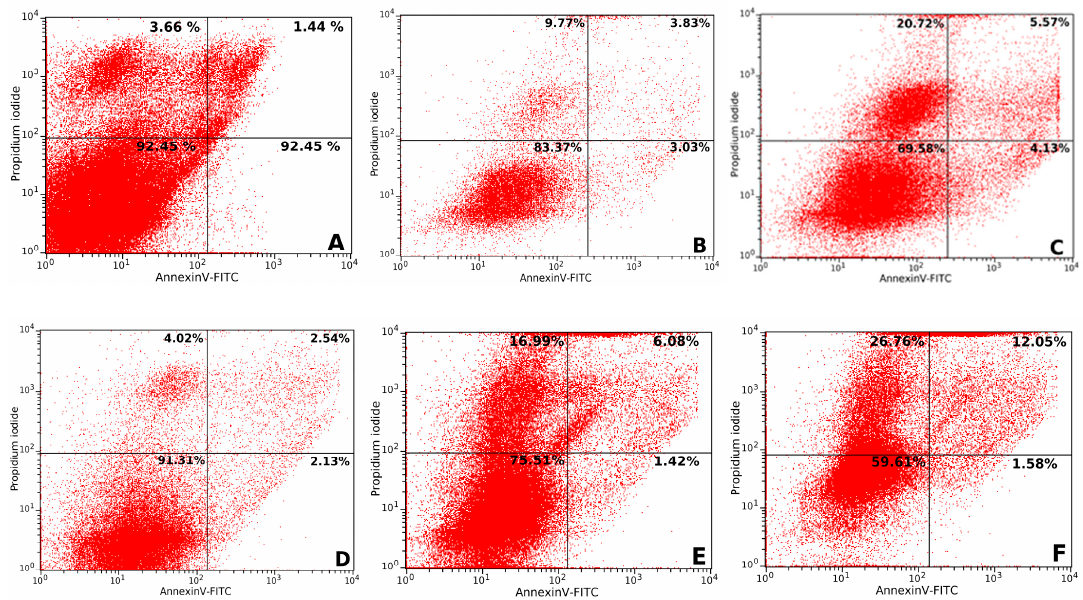
Figure 6. The frequency of distribution of viable, dead, pre-apoptotic and apoptotic cells in UBE-treated CAL 27 cell cultures, at concentrations of 100 and 200 µg/mL. These results represent the mean ± SE of three independent experiments (** p < 0.01 and *** p < 0.001) when comparing the effects of UBE with the untreated control (t-test).